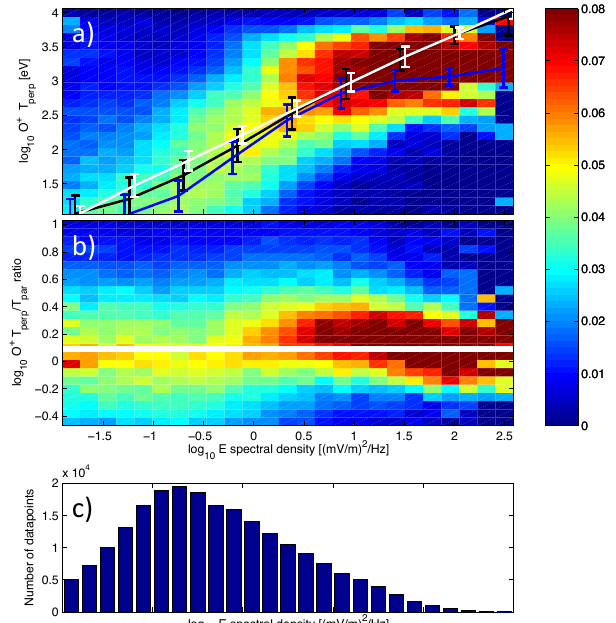
Fig. 1. (a) Distribution of O + perpendicular temperature [log eV] for each interval of electric field spectral density [log (mVm − 1 ) 2 Hz − 1 ]. Each column is normalized; the sum of all data bins in a column is 1. The white line is the predicted perpendicular temperature from the asymptotic mean-particle approach. The white error bars show the standard deviation for the logarithmic value. The black line is the predicted perpendicular temperature from the test- particle approach. The black error bars show the standard deviation for the logarithmic value. The blue line is the average observed per- pendicular temperature. (b) Distribution of O + temperature ratio T ⊥ /T k for each interval of electric field spectral density. The white line is the predicted temperature ratio from the mean-particle ap- proach. (c) Number of data points contributing to each